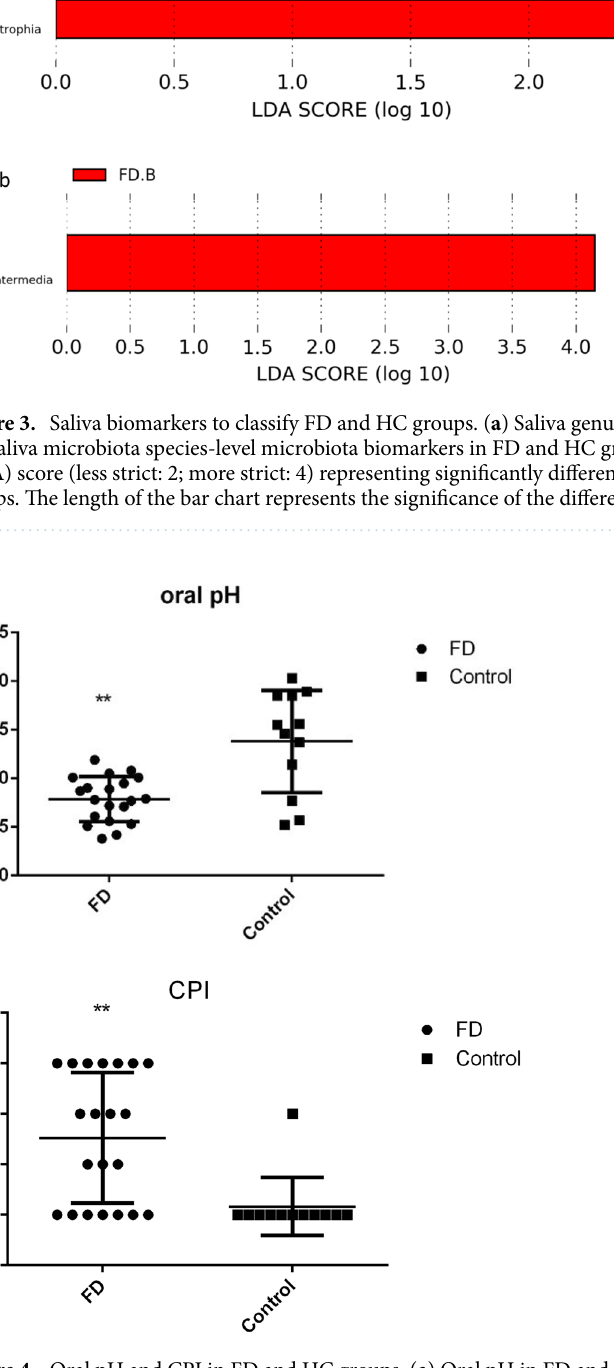
Figure 4. Oral pH and CPI in FD and HC groups. ( a ) Oral pH in FD and HC groups. * p < 0.05; ** p < 0.01; ( b ) CPI in FD and HC